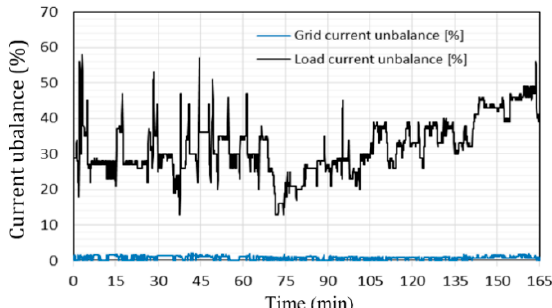
Figure 23. Evolution of load current unbalance (in black) and grid current unbalance (in blue) during recordings (%).